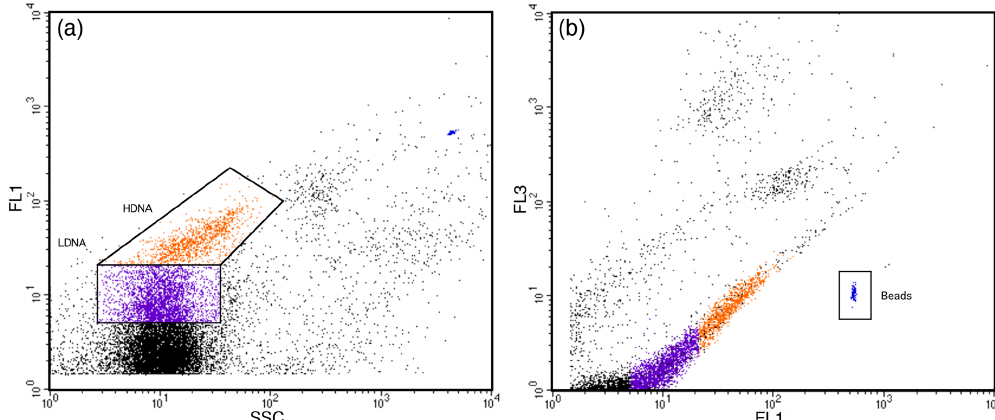
Figure 3. Prokaryote regions identified by flow cytometry. (a) SYBR-Green I-stained high-DNA (HDNA) and low-DNA (LDNA) prokaryote regions identified from side scatter (SSC) versus green fluorescence (FL1) scatter plots. (b) Prokaryote cells determined from high FL1 versus low red (FL3) fluorescence. PeakFlow Green 2.5µm beads were used as fluorescence and as a size